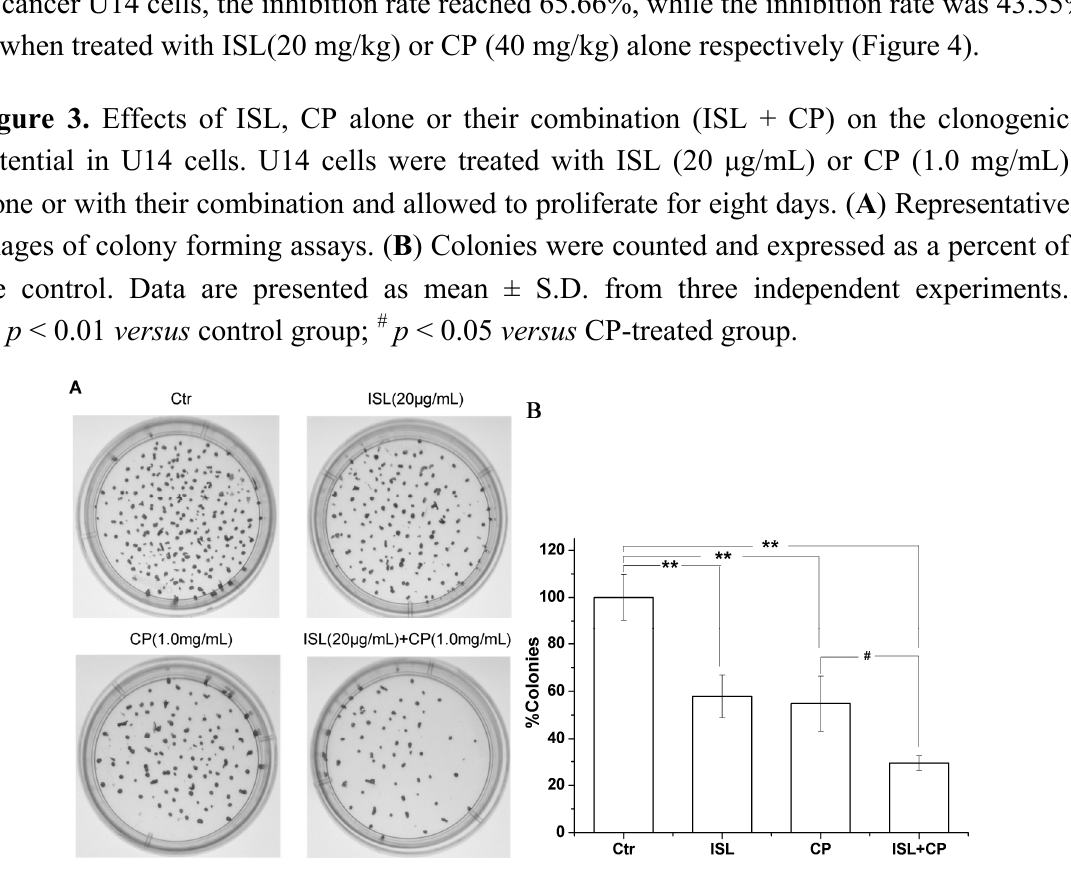
Figure 4. Synergestic inhibition of ISL and CP on tumour growth in vivo . KM mice bearing cervical cancer U14 cells were administrated with ISL (5~20 mg/kg, orally administered once a day for 10 consecutive days) or CP (40 mg/kg, injected by intraperitoneally a single dose of 40 mg/kg body weight at the first day). The implanted sarcomas were separated and weighed on day 11. ( A ) Images of the tumour morphology. ( B ) The quantitative results of tumor growth-inhibition. Data are presented as mean ± S.D. from 10 individual treatments. * p < 0.05; ** p < 0.01 versus control group; # p < 0.05; ## p < 0.01 versus CP-treated